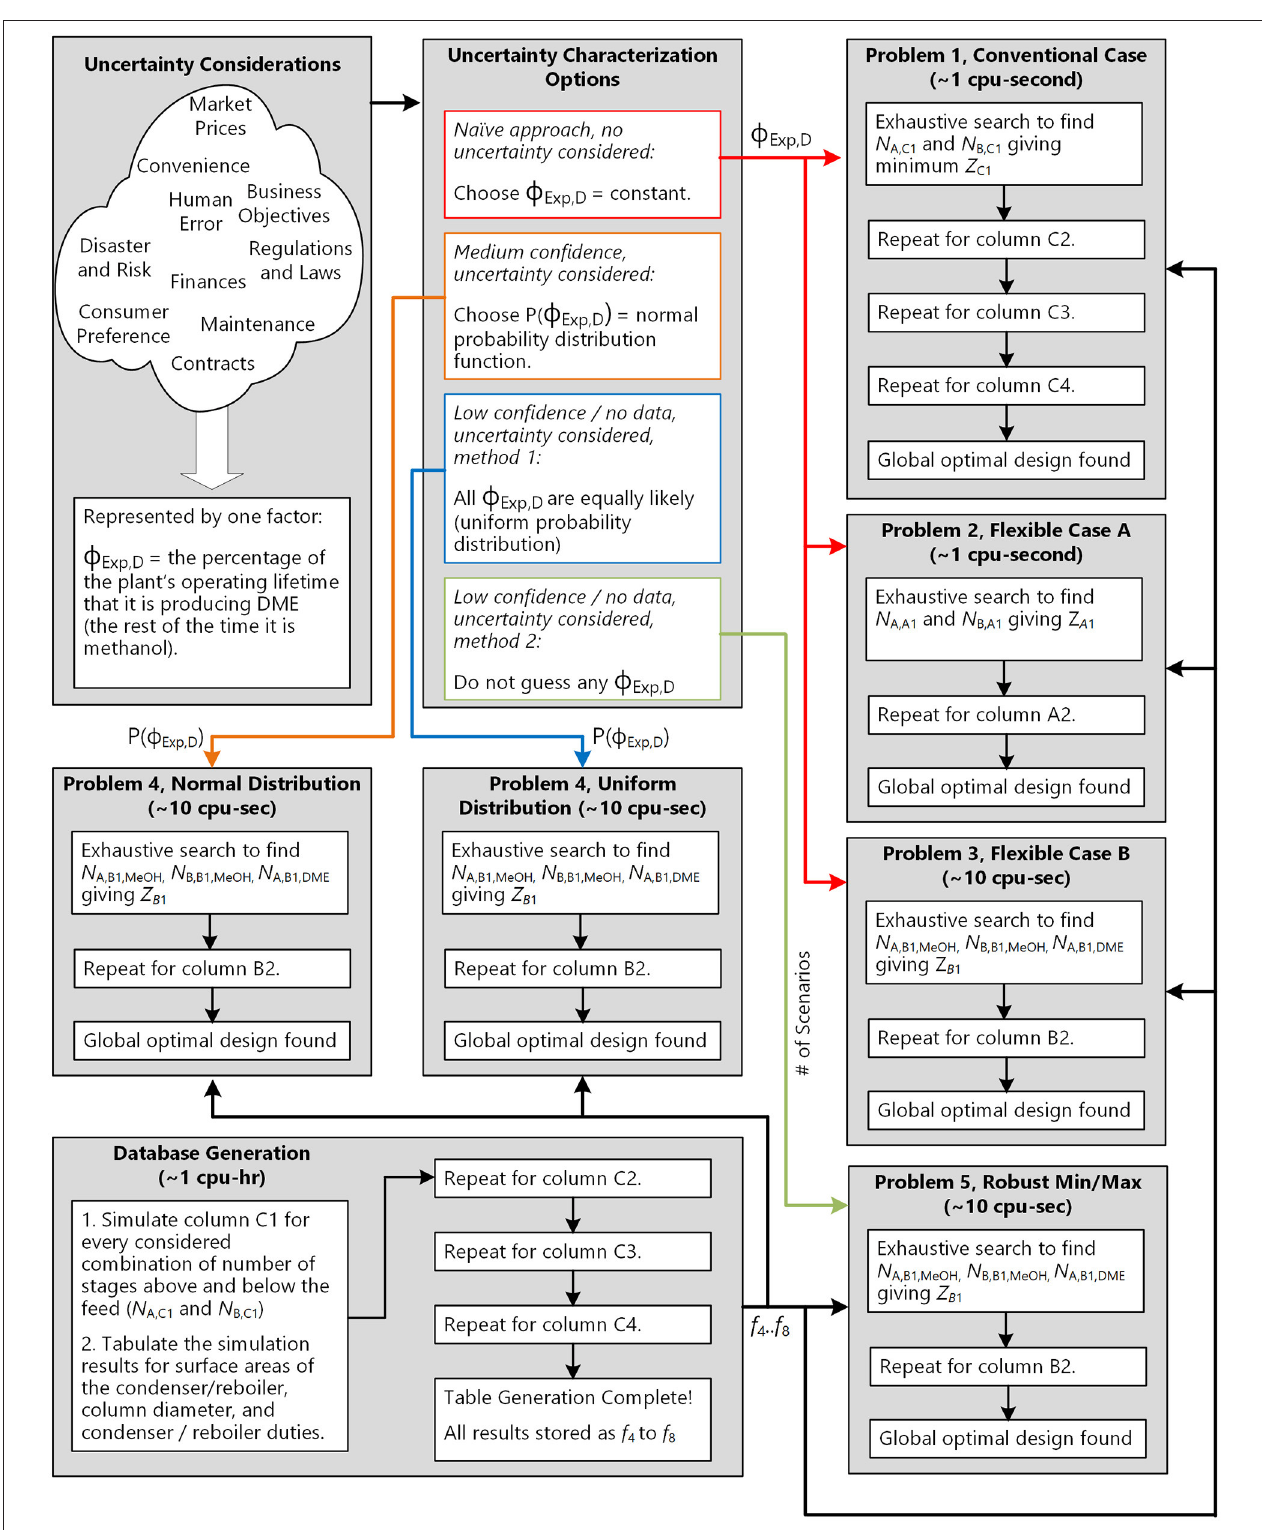
FIGURE 12 | A summary of the methodology used in this work. Essentially, the results of the single database generation step can be re-used in a variety of different problem formulations based on the design concept and the market uncertainty characterization.